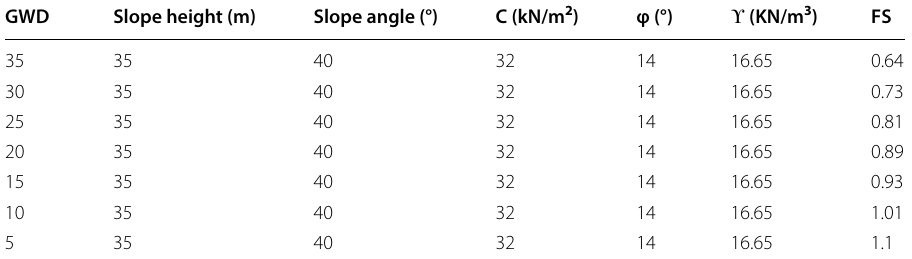
Table 11 Impact of groundwater reduction on slope factor of safety GWD